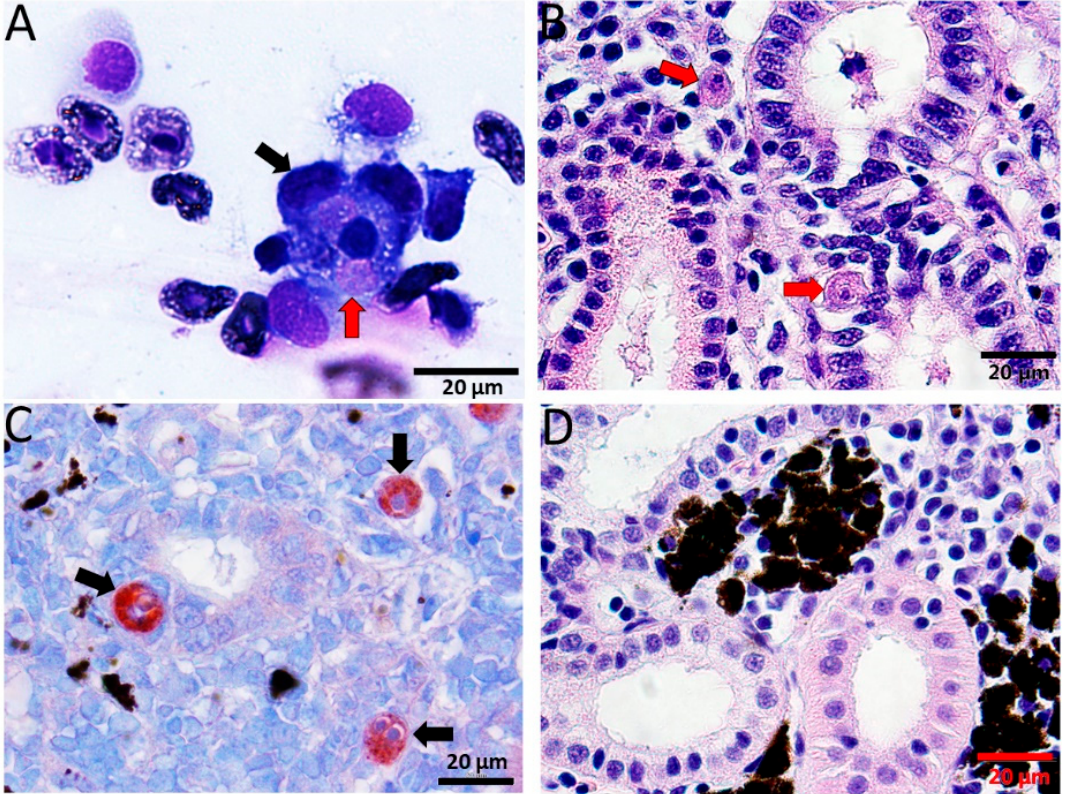
Figure 2. Diff-Quick stained blood smear and histological sections of kidney of infected brown trout. ( A ) Macrophages (black arrow) attached to the T. bryosalmonae (red arrow); ( B ) H&E stained sections showing presporogonic stages of the parasite (red arrows) in the renal interstitium and renal tubule; ( C ) immunostained sections showing parasitic stages in renal interstitium and tubular epithelium (black arrows); ( D ) H&E stained sections from control kidney showing normal renal structure.